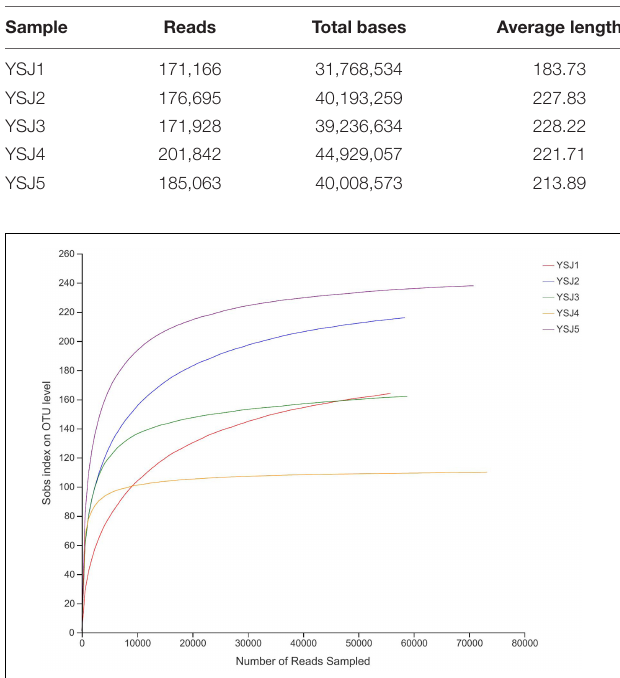
TABLE 1 | Average internal transcribed spacer (ITS) reads of fungal endophytes in Alpinia zerumbet seeds at five stages.